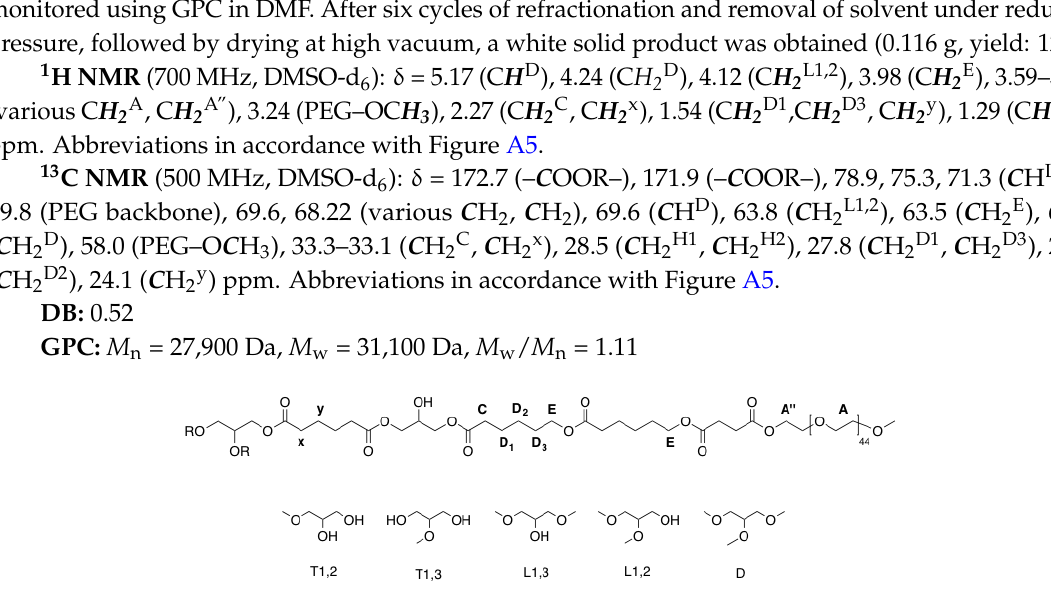
Figure A4. Labelling of atoms of mPEG-COOH used for NMR description.